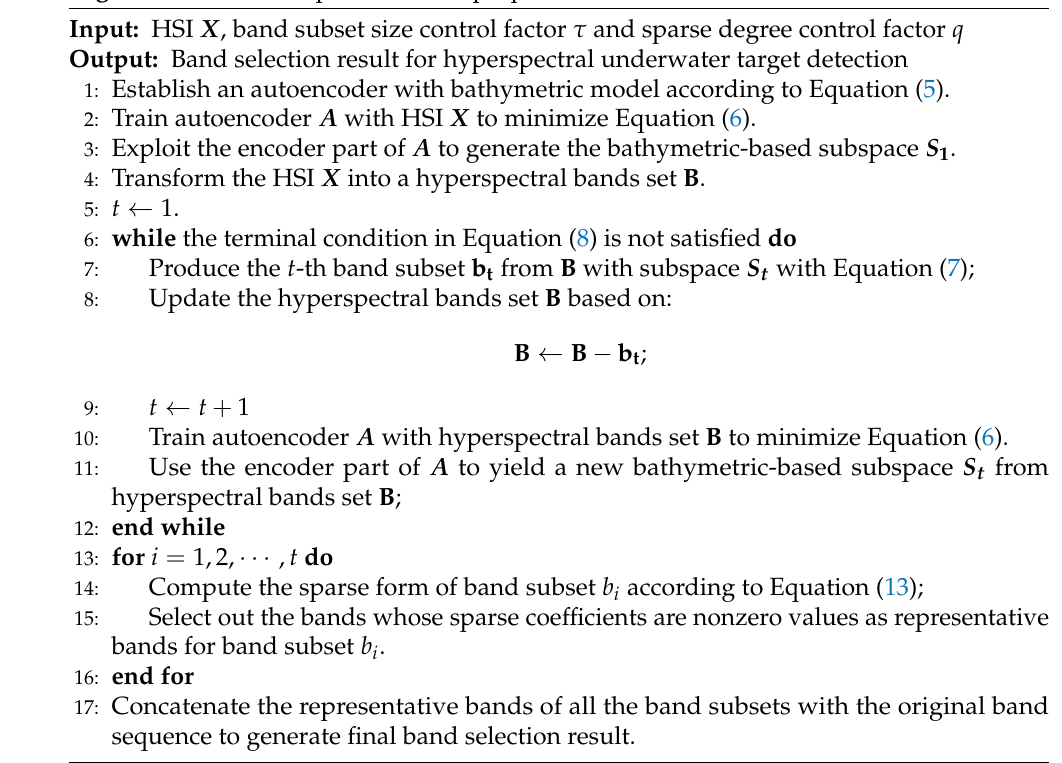
Algorithm 1 The total process of the proposed